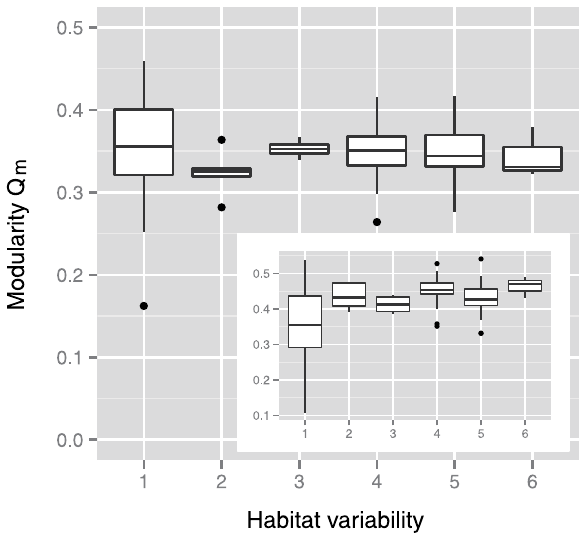
Figure 1. Correlation between network modularity and habitat variability in a natural habitat. Metabolic networks constructed from the latest version of the database show no correlation ( p =0.61 using the Kruskal-Wallis (KW) test; Spearman’s rank correlation coefficient r s = 2 0.03 and p =0.78). Metabolic networks constructed from the early version of the database (inset) demonstrate a positive correlation ( p =0.0001 using the KW test; r s =0.31 and p =0.0008).